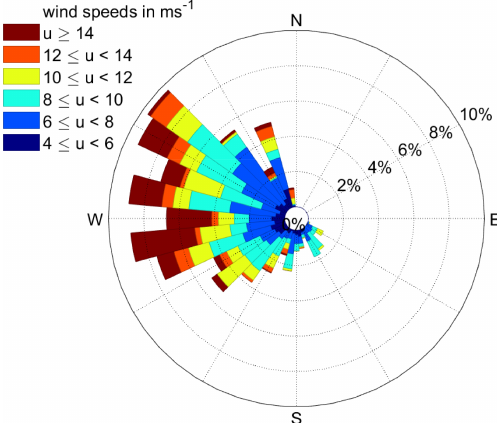
Figure 2. Wind speed and wind direction distribution extracted from horizontal PPI lidar scans of the 9438 analysed time